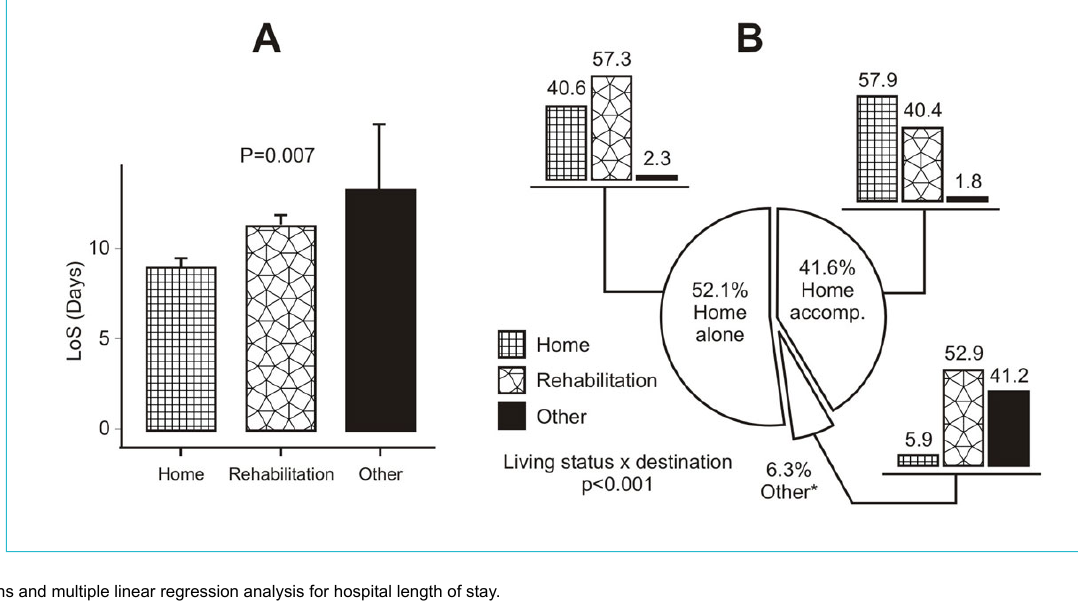
Table 2: Univariate correlations and multiple linear regression analysis for hospital length of stay.